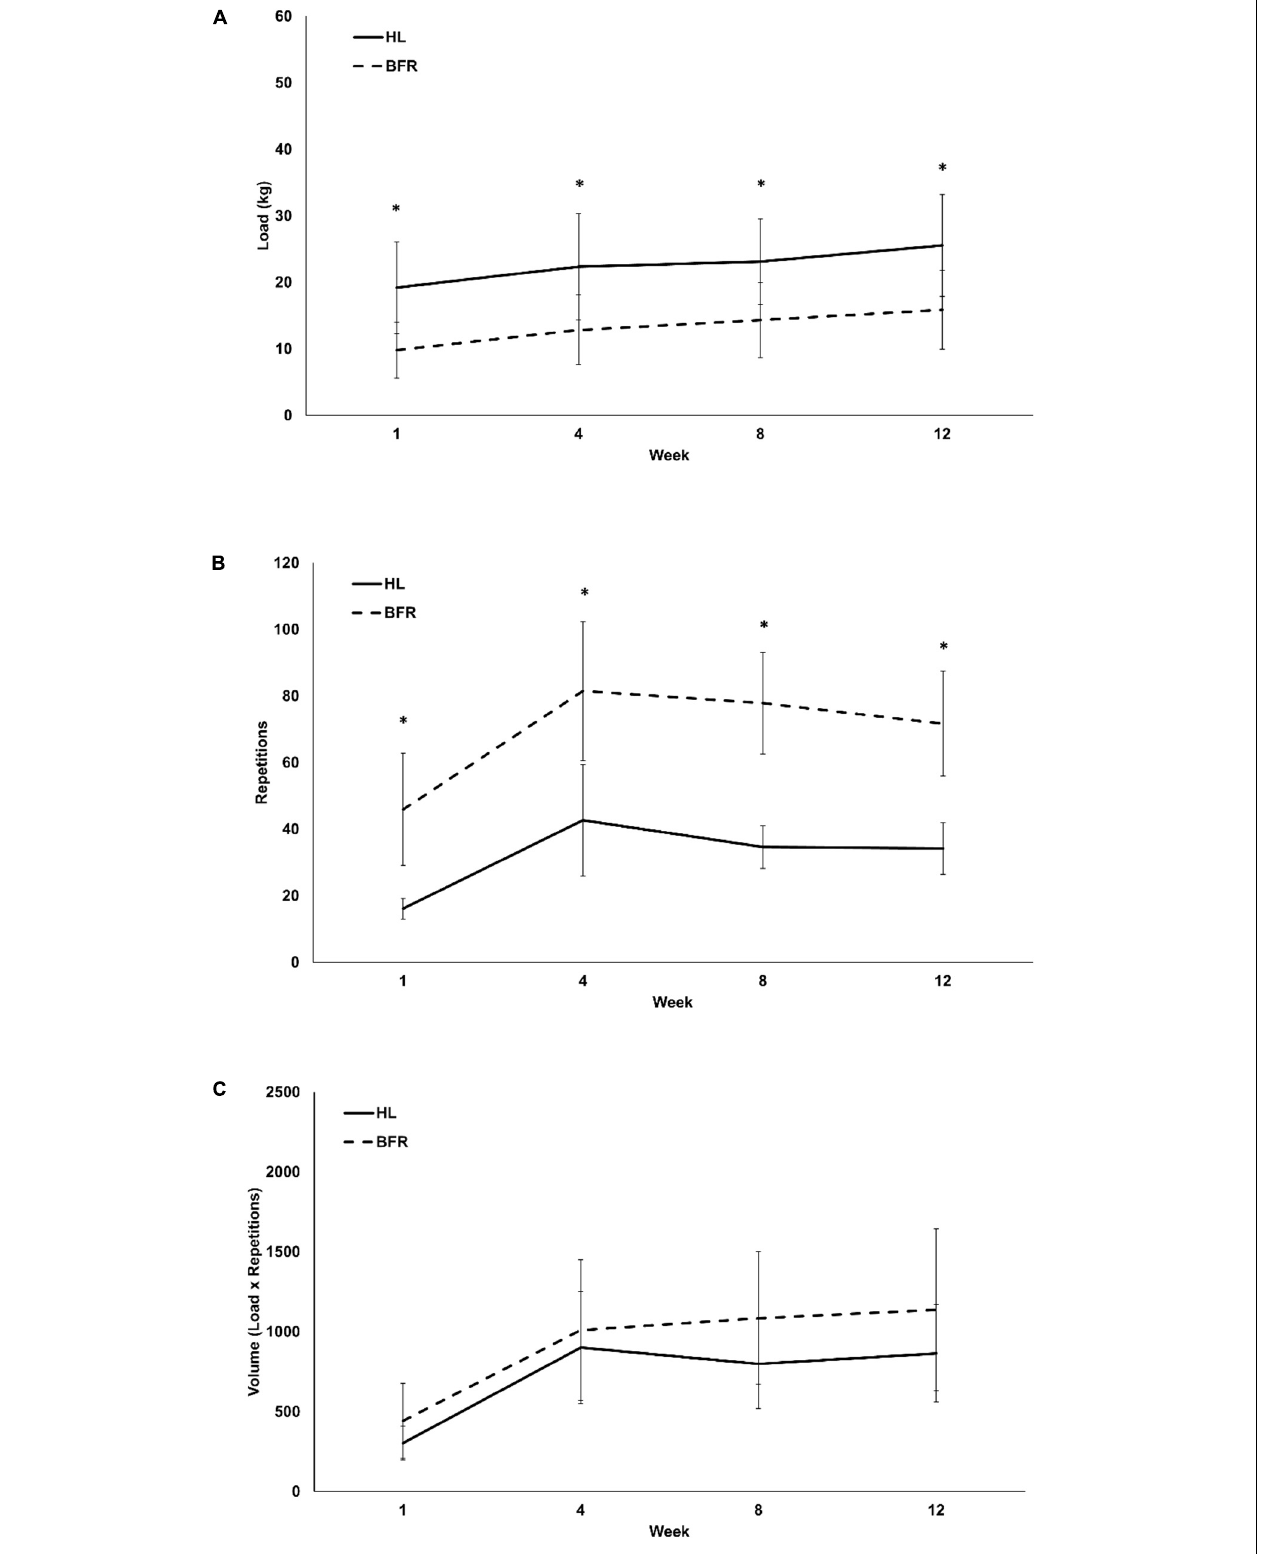
FIGURE 2 | Monthly load (A) , repetitions (B) , and volume (C) of HL and low-load blood flow restricted (BFR) knee flexion resistance training. ∗ denotes significant difference between HL and BFR.